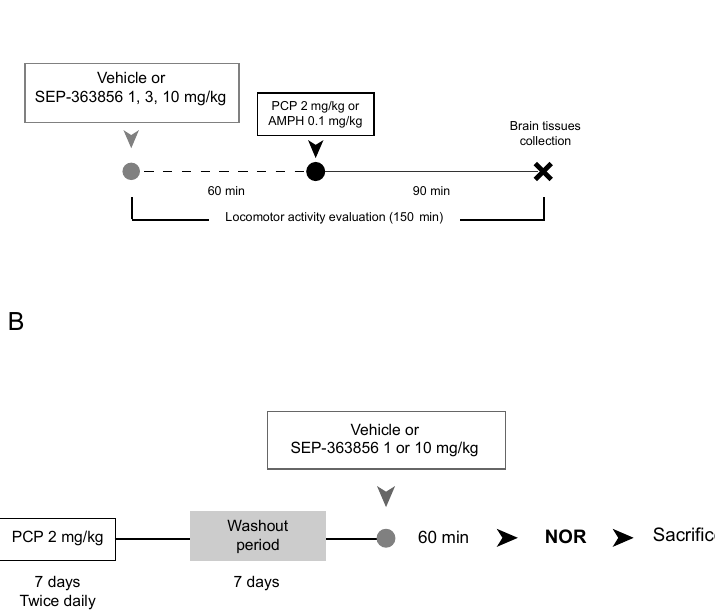
Figure 8. Schematic representation of the experimental paradigms. Acute Phencyclidine and D- Amphetamine Treatments ( A ). Animals received an oral administration of SEP-856 or vehicle. Following the 60 min pretreatment time, rats received a second injection of vehicle, phencyclidine (PCP) or d-amphetamine (AMPH). Ninety minuites after the second injections, following locomotor activity assessment, animals were sacrificed by decapitation ( A ). Subchronic Phencyclidine Treatment ( B ). Animals were treated with phencyclidine (PCP) or vehicle twice daily for seven days. Following a seven-day drug-free period, rats received an oral administration of SEP-856 or vehicle. Sixty minutes later, animals performed the novel object recognition (NOR) test ( B ).